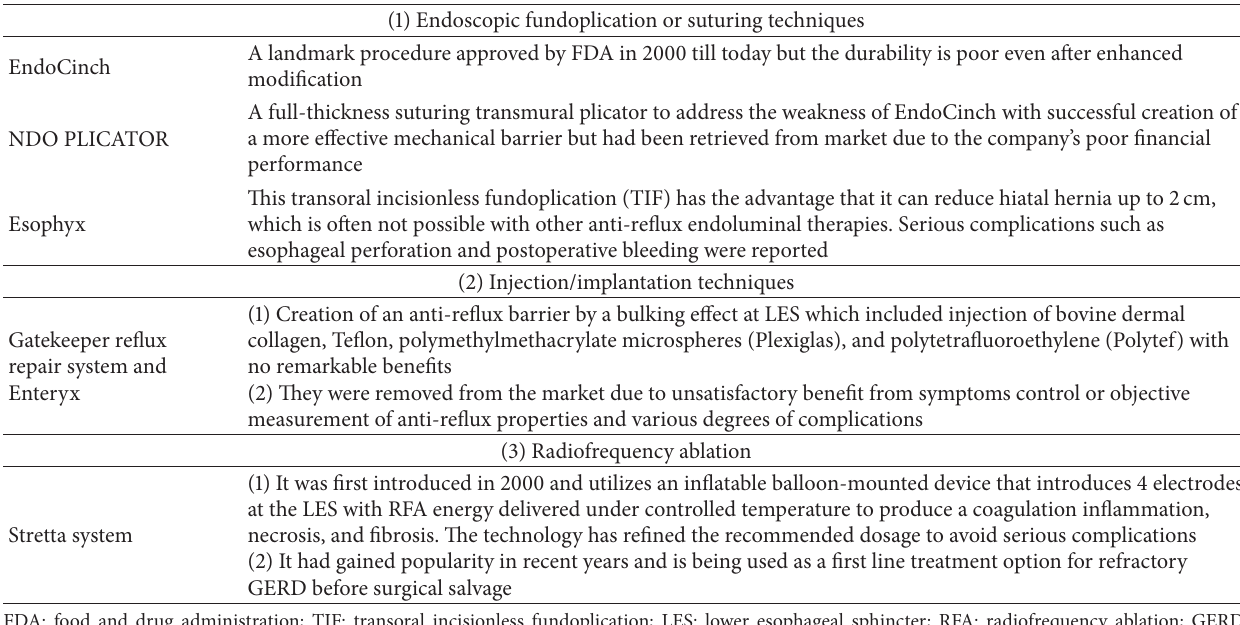
Table 1: Anti-reflux endoluminal therapies. (1) Endoscopic fundoplication or suturing